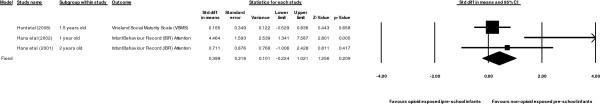
Forrest plots comparing behaviour in opiod and non-opiod exposure.